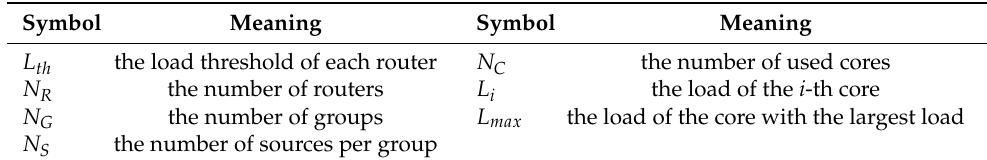
Table 1. The meaning of symbols in this